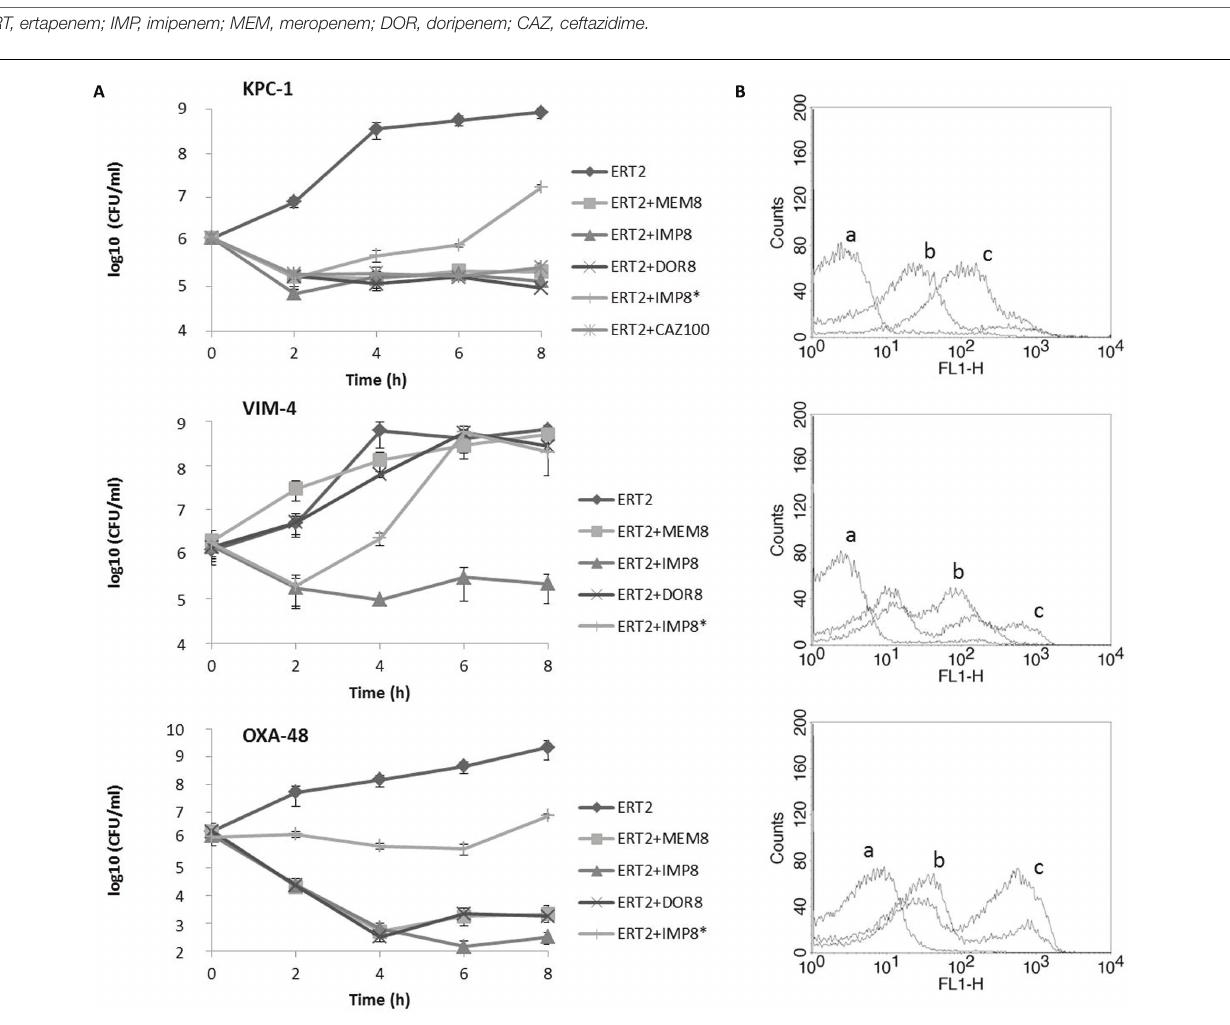
Frontiers in Microbiology |